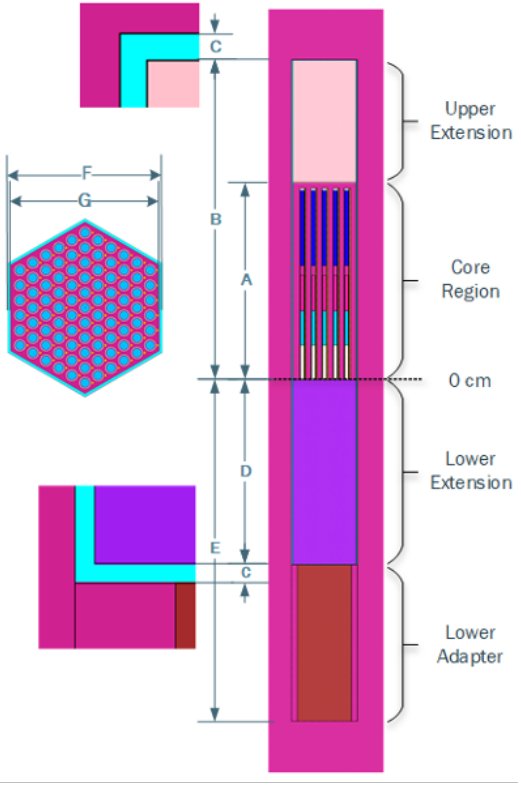
Figure 3. EBR-II driver assembly